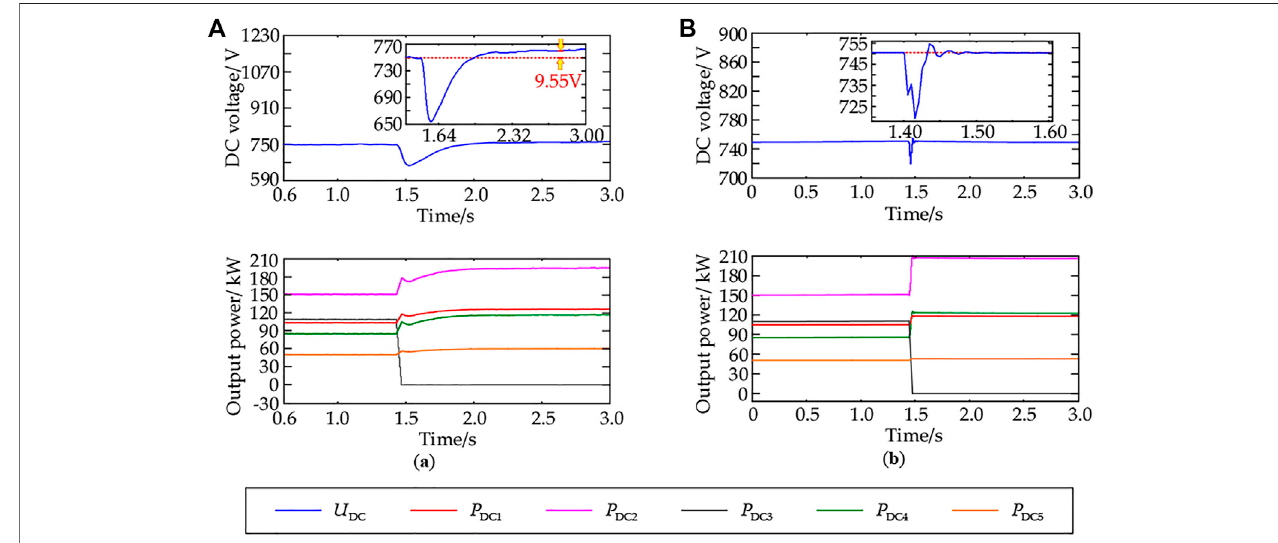
FIGURE 9 | Simulation waveforms of the VSC with droop control exiting operation: (A) simulation waves based on traditional droop control; (B) simulation waves based on adaptive droop control.